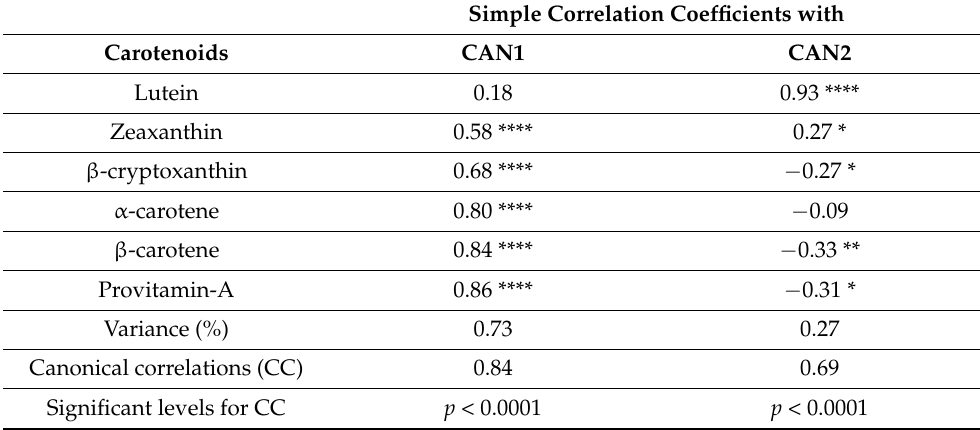
Table 2. Simple correlations between coefficients of each canonical discriminant function (CAN1 and CAN2) and the best linear unbiased predictors (BLUPs) of individual carotenoids, including provitamin A of 64 hybrids evaluated across 23